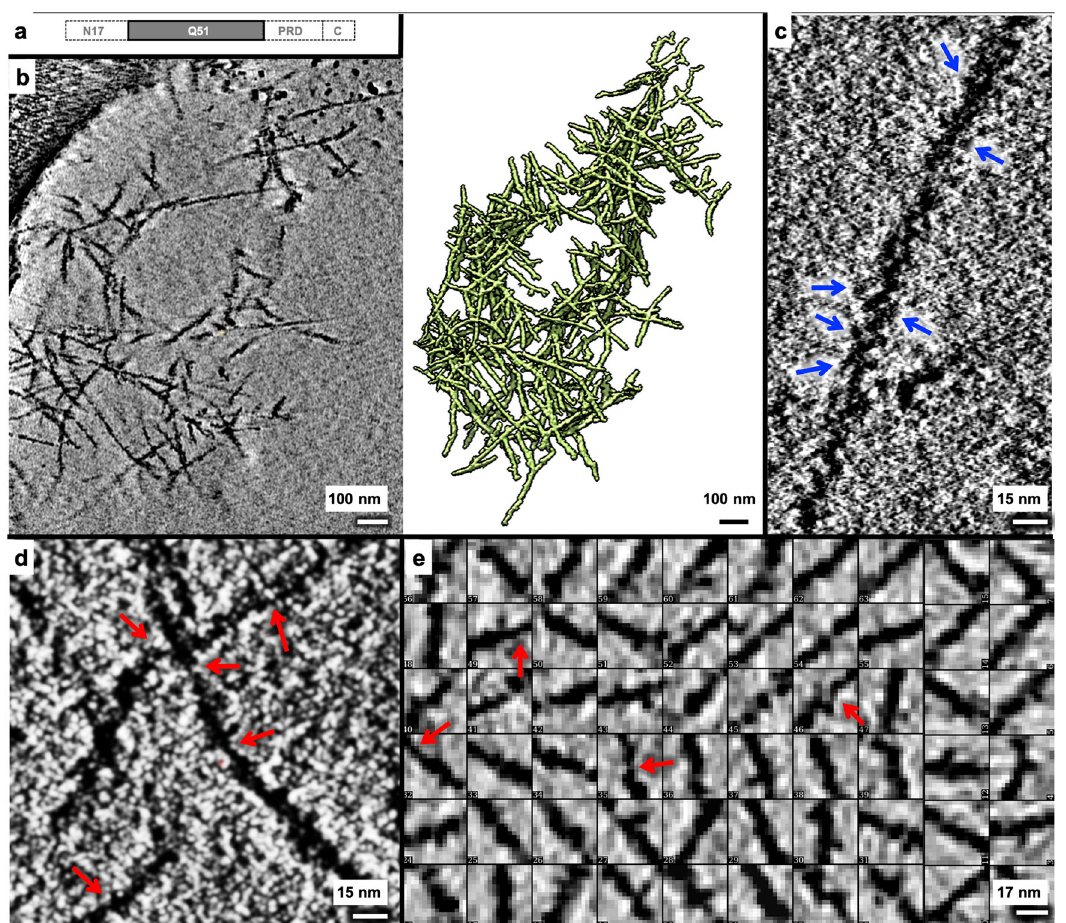
Fig. 3 Lumpy Q51 fi laments exhibit a large range of widths. a Schematic of the Q51 construct, lacking all mEx1 domains except for the polyQ tract. b Slice parallel to the xy plane (~2.1 nm thick) through a representative 4x downsampled cryoET tomogram of aggregated Q51 reconstructed with compressed sensing and corresponding 3D annotation. Zoomed-in views of xy slices (~0.5 nm thick) from selected regions of the tomogram shown in “ a ” but without any downsampling, exhibiting c a pseudo-periodic pattern of repeating lumps along the length of a Q51 fi lament (blue arrows), and d regions in thin fi laments that are as thin as ~2 nm in width (red arrows). e Examples of 2D xy slices through representative 3D subtomograms of Q51 fi lament segments showing a wide variation in width, including super-thin regions ~2 nm in width (red arrows). Scale bars: 100 nm ( b ), 15 nm ( c , d ), and 17 nm ( e